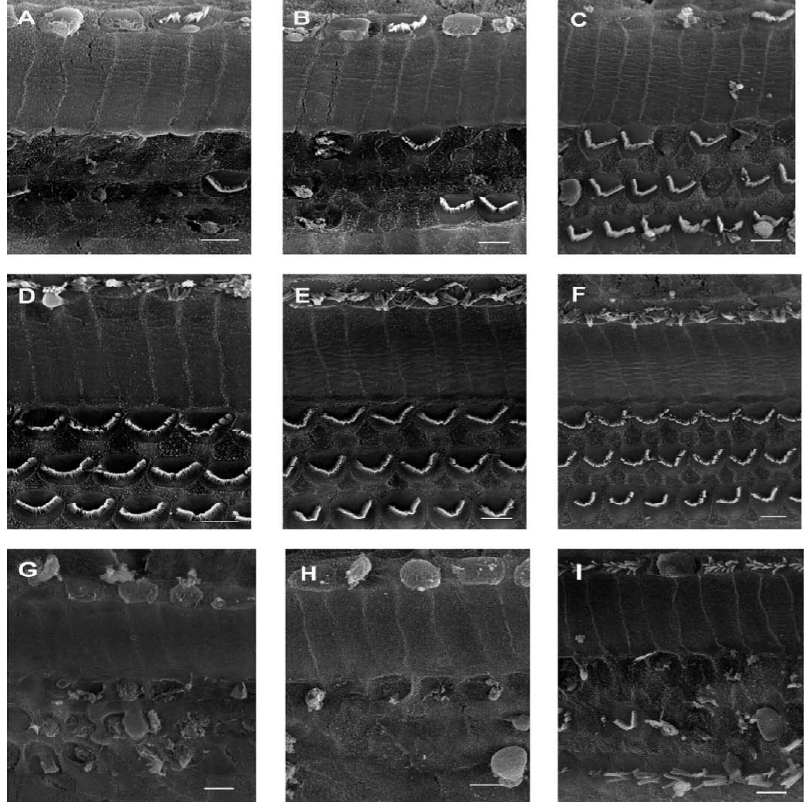
Figure 2. Protection of rat cochlear outer hair cells from cisplatin-induced damage by A AR agonist, R-PIA. Rats were pre-treated with R-PIA (10 µL of a 10 µM solution added 1 to the round window). The remaining liquid was removed after 1 h and rats were administered cisplatin by intraperitoneal injections (16 mg/kg). Panels A – C are electron micrographs of the organ of Corti from rats treated with cisplatin and represent the hook, basal turn and the middle turn, respectively; Panels D – F shows the effect of pre-treatment with R-PIA for the respective regions; Panels G – I show the effect of R-PIA in presence of DPCPX, an A AR antagonist, on cisplatin-induced damage. The inner hair cells are the 1 three rows of cells with the “V” shaped stereociliary bundles. The inner hair cells are barely visible on the top of each micrograph. The data which was confirmed from different AR against cisplatin ototoxicity. cochlear preparations support a protective role of the A 1 (Reprinted with permission from [134], Copyright 2004 Elsevier). Scale bar = 5